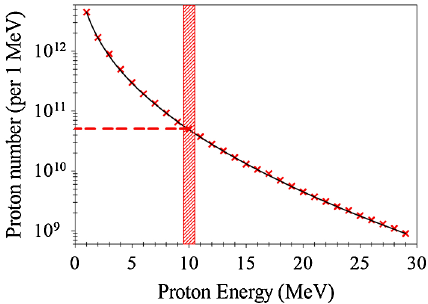
FIG. 1. Dependence of differential particle yield on energy for PHELIX experiment